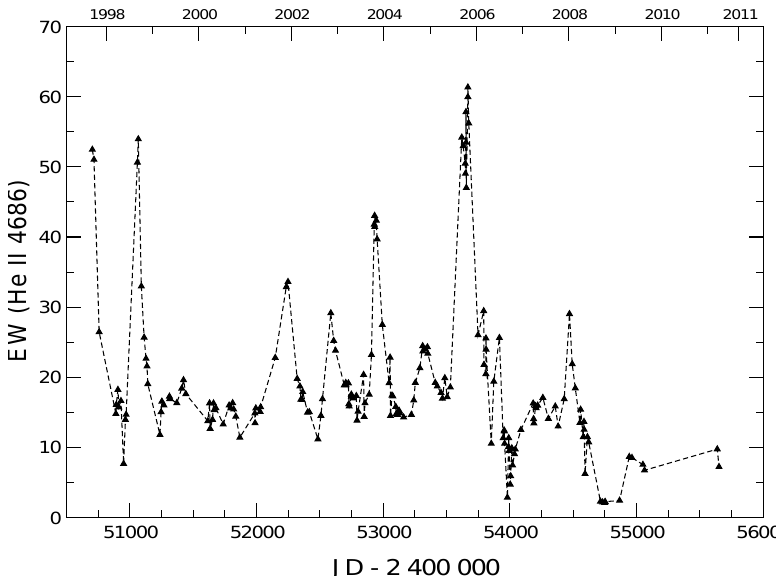
Fig. 4. EWs of the He II (cid:21) 4686 line in the spectrum of AG Dra in